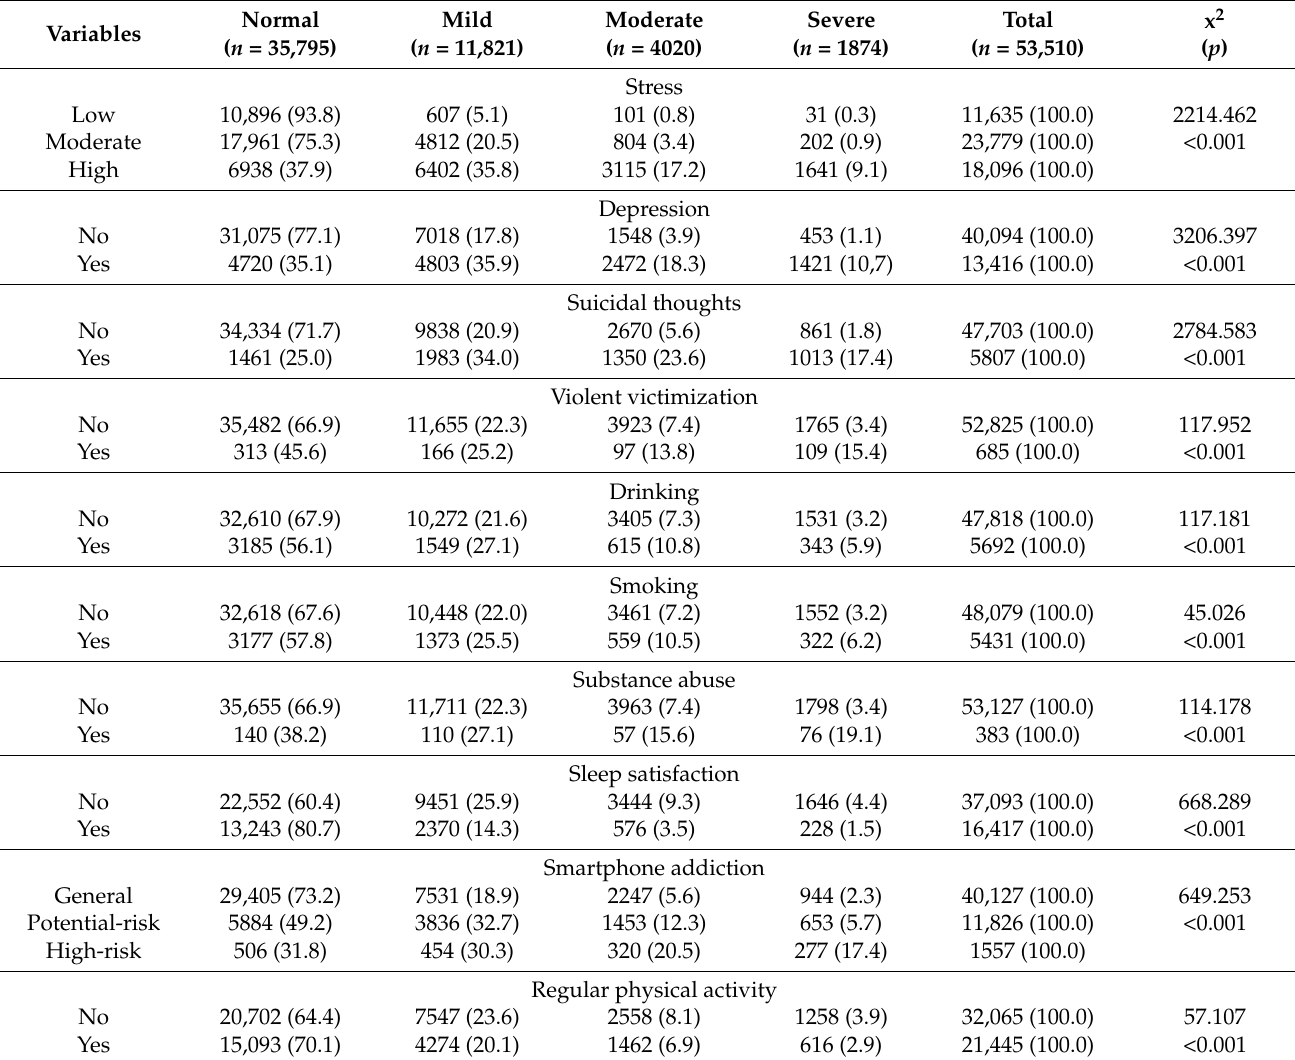
Table 2. Differences in health risk behaviors according to level of